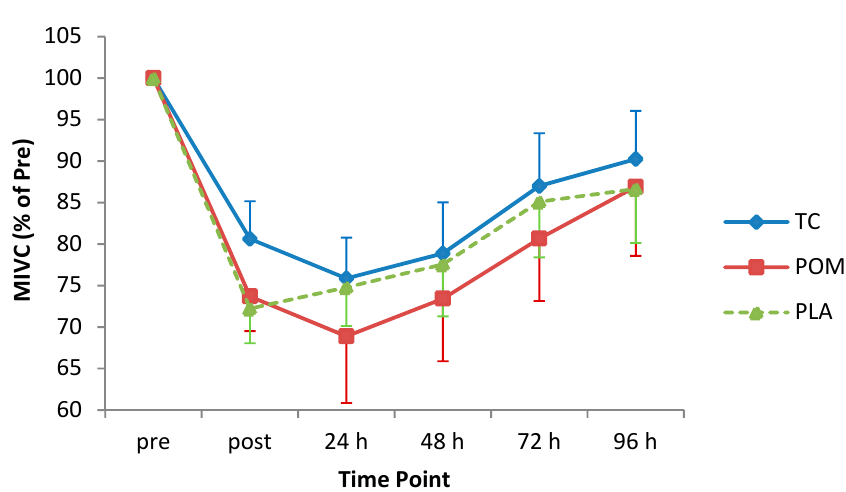
Figure 2. Change in maximal isometric elbow flexion strength following eccentric exercise (expressed as a percentage of pre-exercise strength). Values are an average of five maximal contractions and are displayed as mean (± SEM). Time by treatment, p = 0.91. MIVC = maximal isometric voluntary contraction; TC = tart cherry; POM = pomegranate; PLA = placebo, n = 11 for each group.